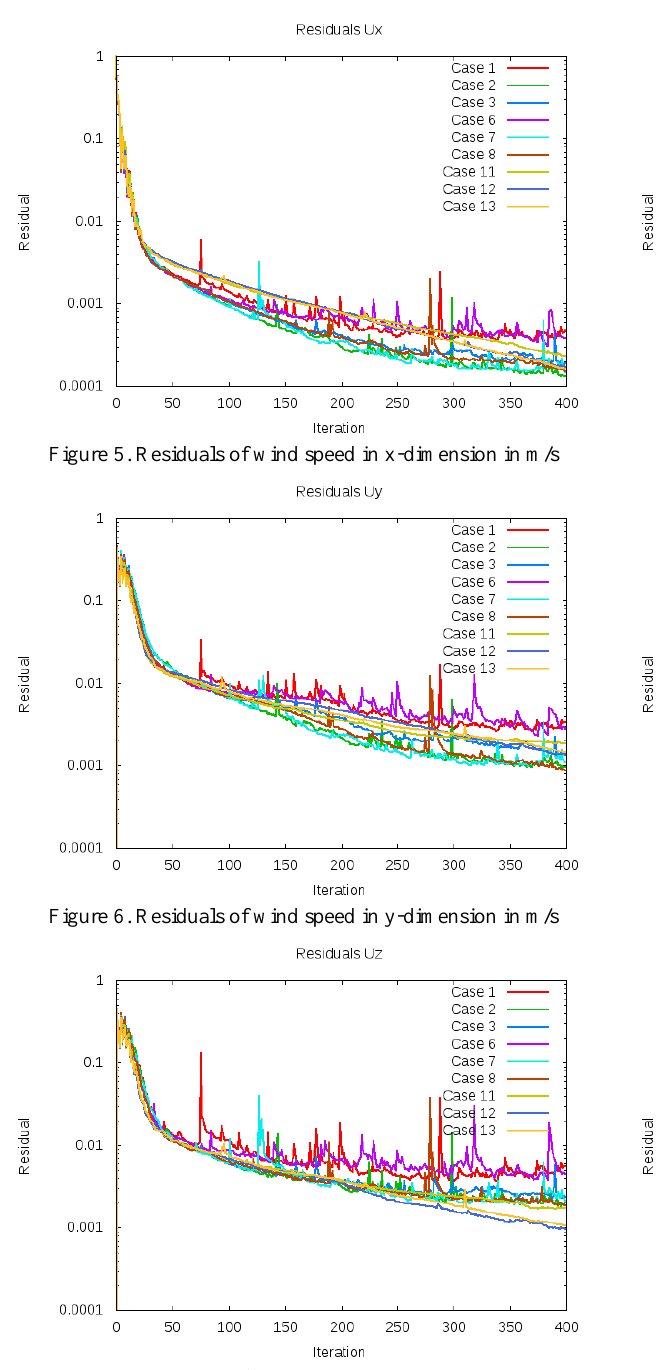
Figure 10. Residuals of turbulence model ε